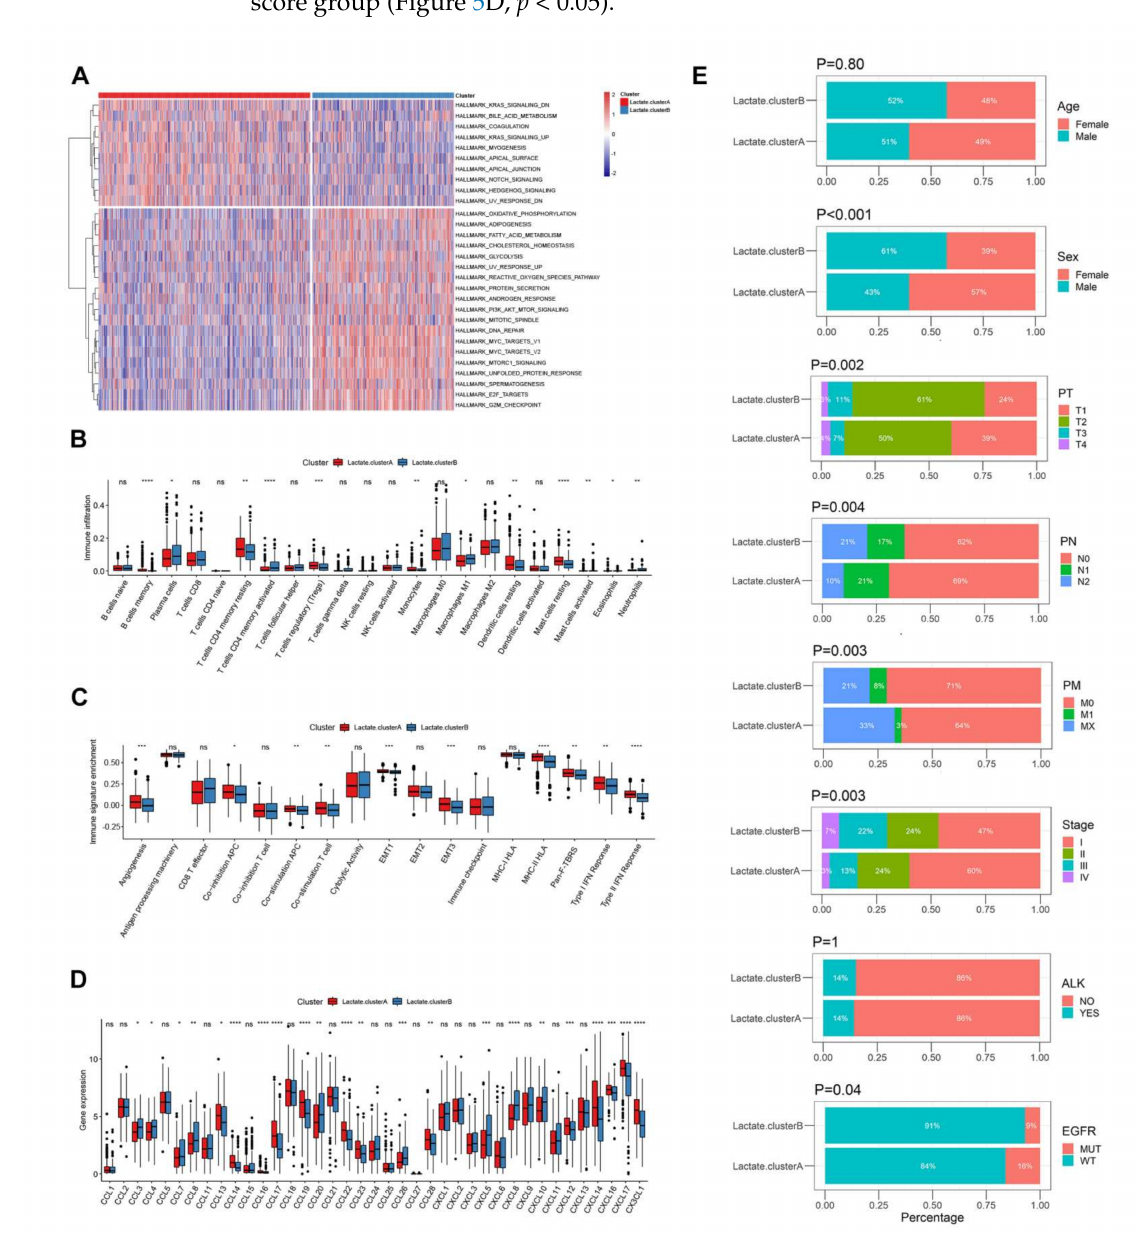
Figure 3. Biological function and TME characteristics in two lactate metabolism-associated genes patterns. ( A ) The top 29 significantly different pathways between two patterns, which were analyzed by GSVA. ( B ) Various kinds of immune cell infiltration in two clusters. ( C ) Immune signature enrichment of two groups that were analyzed by ssGSEA. ( D ) Different gene expression of chemokines between two clusters. ( E ) Differences in clinical features (sex, stage, PT, PM, PN, and mutation of EGFR and ALK). Wilcoxon-test was used to compare the statistical difference of immune infiltration, signature, and gene expression. Chi-square test was used to compare the clinical